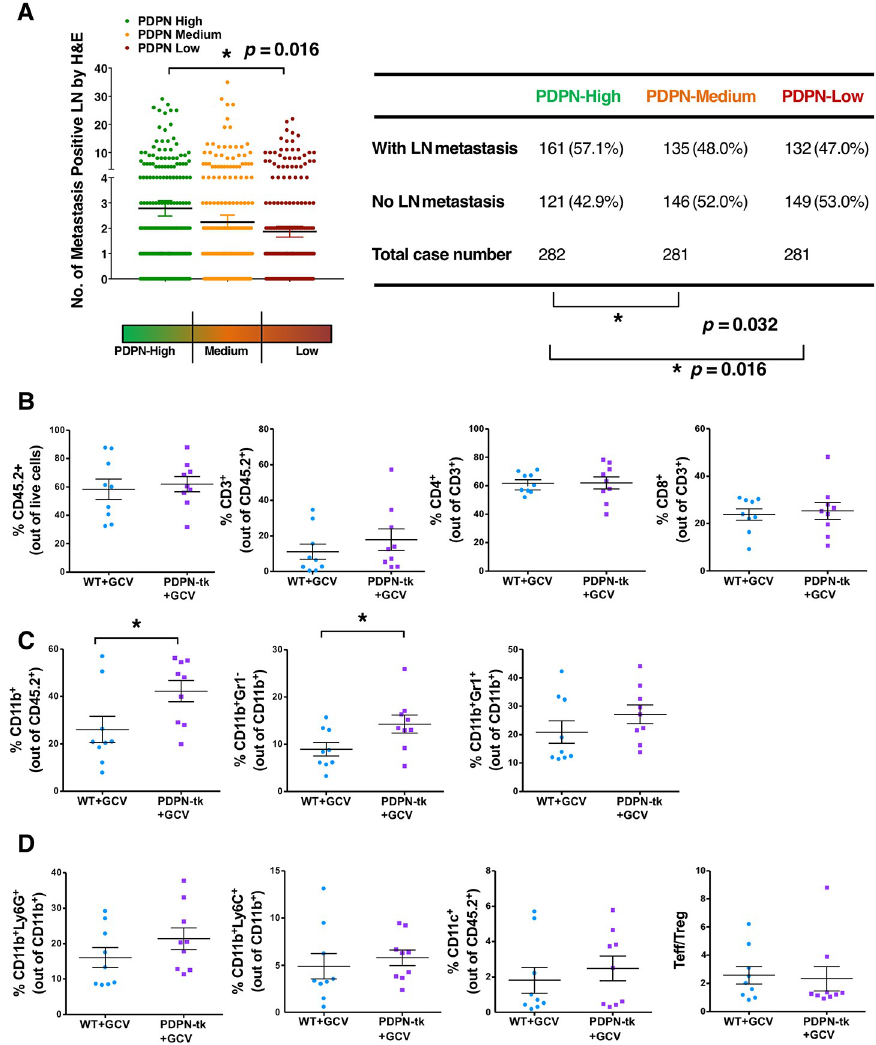
Fig 5. Tumor immune profile when lymphangiogenesis is suppressed. (A) The correlation between PDPN-relative mRNA level and LN metastasis in 844 breast cancer patients with available data for both RNA Seq V2 RSEM and examined LN metastasis count (identified by H&E) from TCGA breast invasive carcinoma data set. PDPN level is presented as relative mRNA expression normalized to the Gapdh housekeeping gene. A table presenting the number of LN metastasis positive cases out of total cases is also shown ( χ 2 analysis). (B) Percentages of CD45 + , CD3 + , CD4 + , and CD8 + cells in 4T1 orthotopic mammary tumors of PDPN-tk or WT mice ( n = 9 mice per group). (C) Percentages of CD11b + , CD11b + Gr1 − (Ly6C − Ly6G − ), and CD11b + Gr1 + cells in 4T1 orthotopic mammary tumors of PDPN-tk or WT mice ( n = 9 mice per group). (D) Percentages of CD11b + Ly6G + , CD11b + Ly6C + , CD11c + cells, and ratio of CD4 + FoxP3 − Teffs to CD4 + FoxP3 + (Treg) in 4T1 orthotopic mammary tumors of PDPN-tk or WT mice ( n = 9 mice per group). Data are represented as mean ± SEM. Significance is determined using an unpaired two-tailed Student t test ( � p < 0.05). The underlying data can be found in S1 Data. CD, cluster of differentiation; GCV, ganciclovir; H&E, hematoxylin and eosin; LN, lymph node; PDPN, podoplanin; RNA Seq V2, RNA Sequencing Version 2 analysis; RSEM, normalized gene expression with RSEM output; TCGA, The Cancer Genome atlas; Teff, effector T cell; tk, thymidine kinase; Treg, regulatory T cell; WT, wild